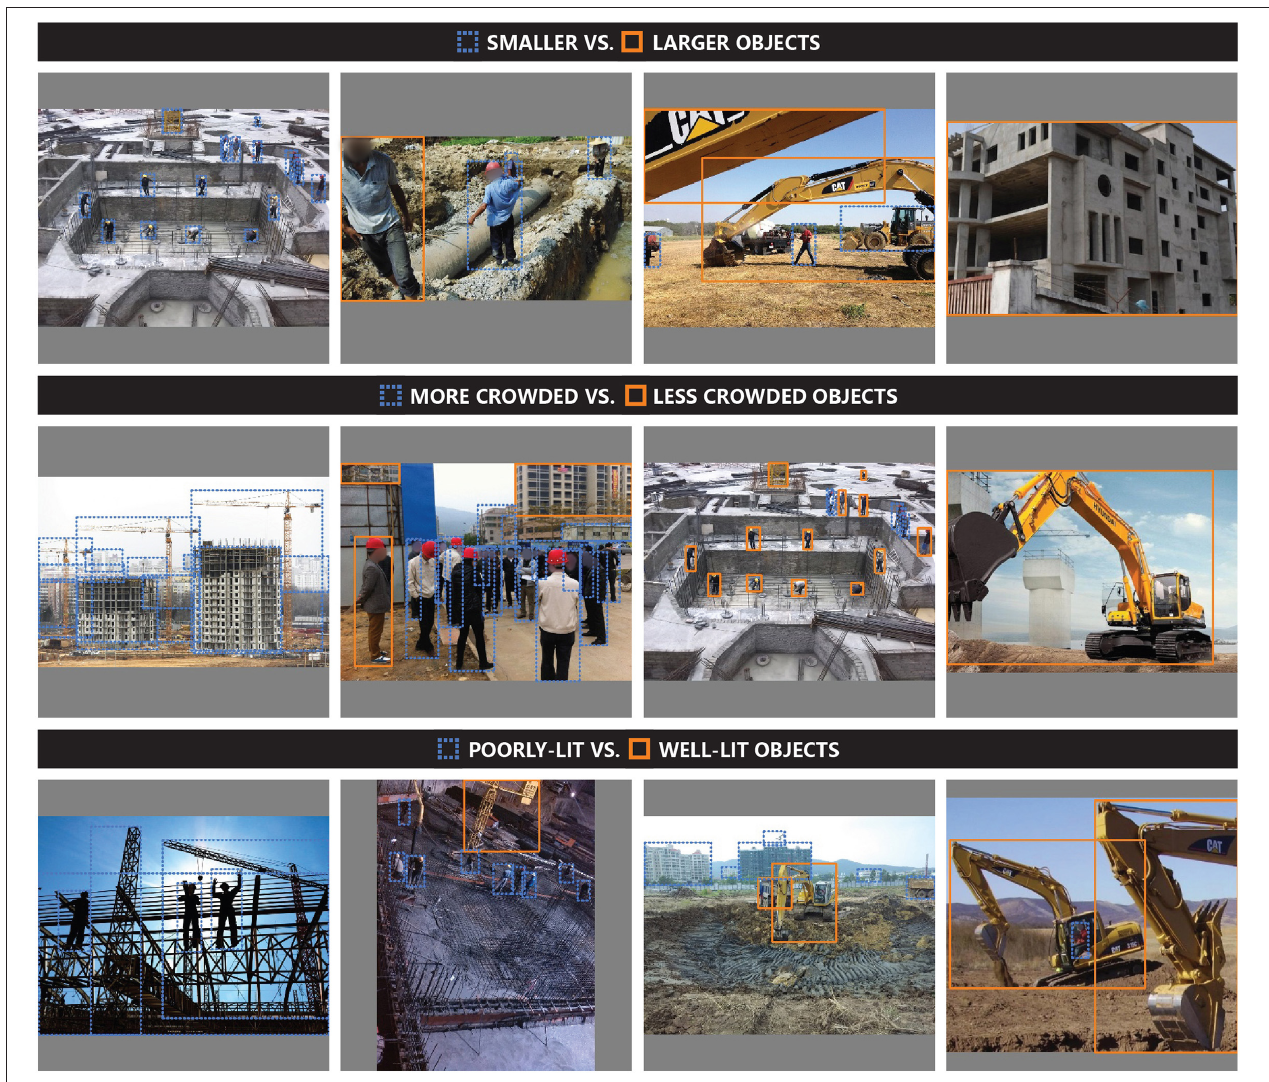
FIGURE 11 | Examples of objects with different constraints (e.g., size, crowdedness, and lighting conditions) in the Pictor-v2